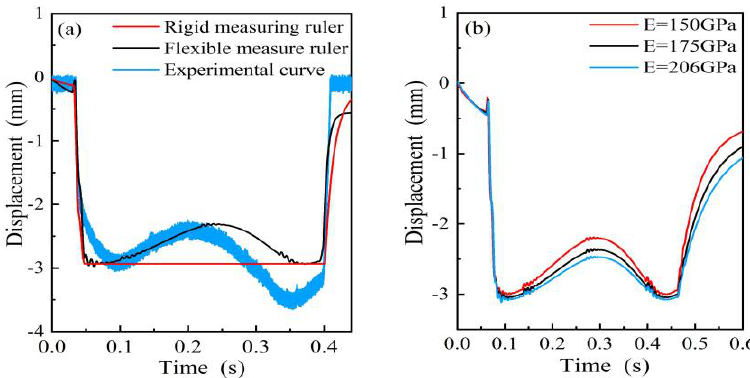
Figure 5. The measuring ruler motion waveform: ( a ) The simulation curve and the experimental curve; ( b ) The motion curve with different Young's modulus.